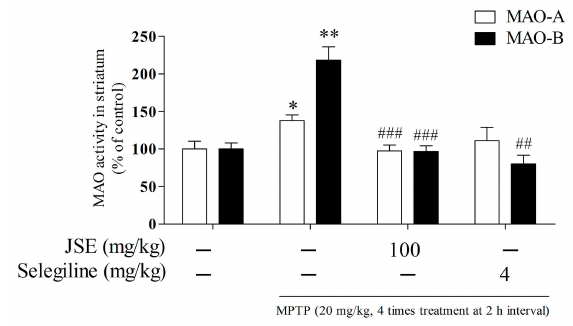
Figure 6. Effect of JSE on MAO activity in in vivo . Monoamine oxidase A and B (MAO-A and B) activities in ST of mouse brain were measured by an MAO kit. Values were expressed as means ˘ SEM. * p < 0.05 and ** p < 0.01 vs. the control group; ## p < 0.01 and ### p < 0.001 vs. the MPTP-only treated